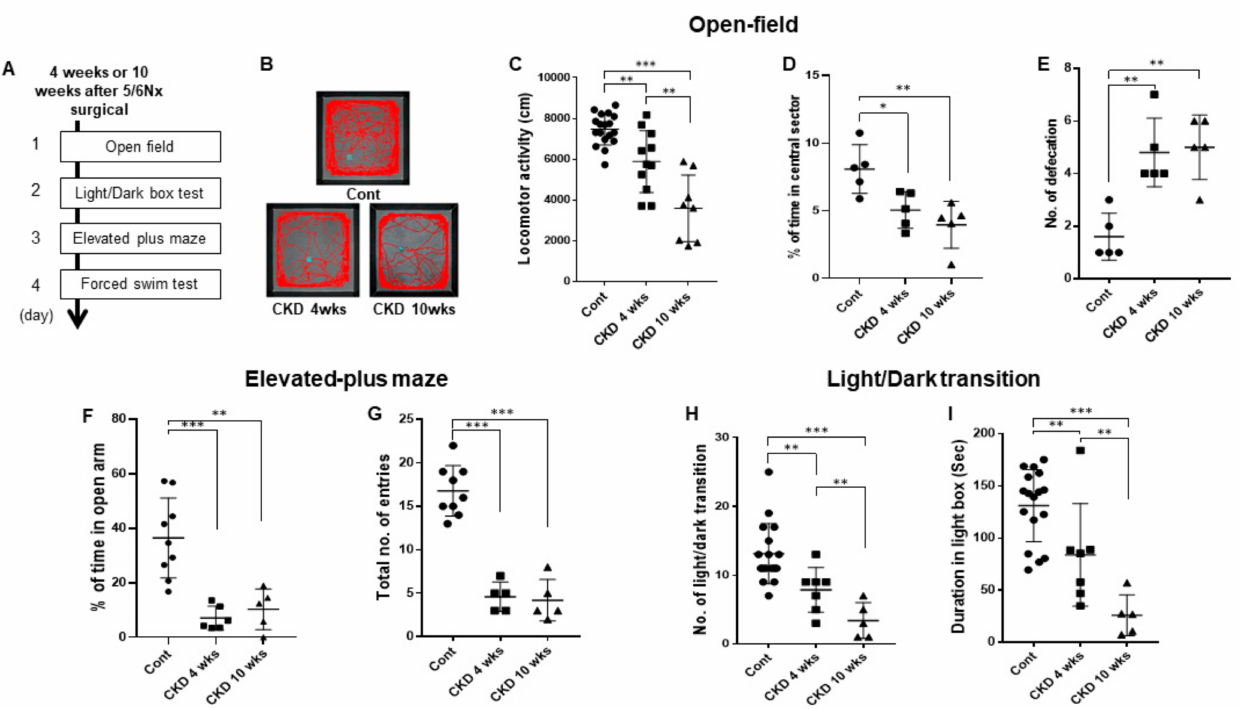
Figure 3. Anxiety-related behaviors in CKD and wild-type rats. Representative diagram shows the overall experimental time schedules ( A ). Representative cumulative traces of navigation pathways of wild-type, CKD 4 week, and CKD 10 week rats during exploratory behavior in the open-field ( B ). Locomotor activity of CKD rat model was decreased as compared with wild-type littermates ( C ). Time spent in the central sector was increased in CKD models and number of defecation was reduced in the open field in CKD groups than wild-type group ( D , E ). Percentage of entries into the open arms and total number of entries in the elevated plus-maze were decreased in the CKD models compared with wild-type rats ( F , G ). In addition, light/dark transition number and total time in the light were lower in the CKD model than wild-type rats ( H , I ). Data are presented as means ± standard errors of the mean. * p < 0.05, ** p < 0.01, and *** p < 0.001, one-way analysis of